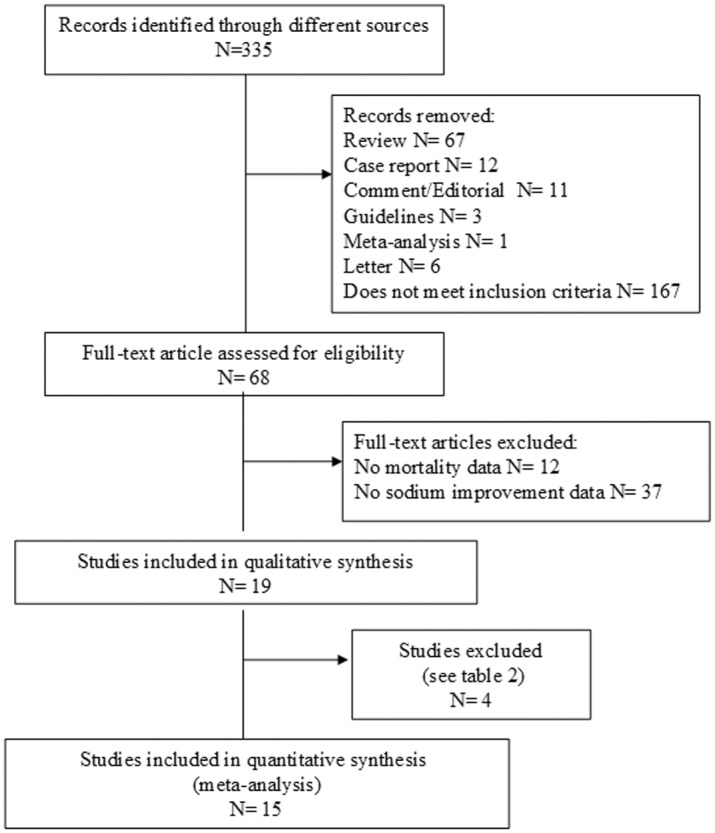
Trial flow diagram.